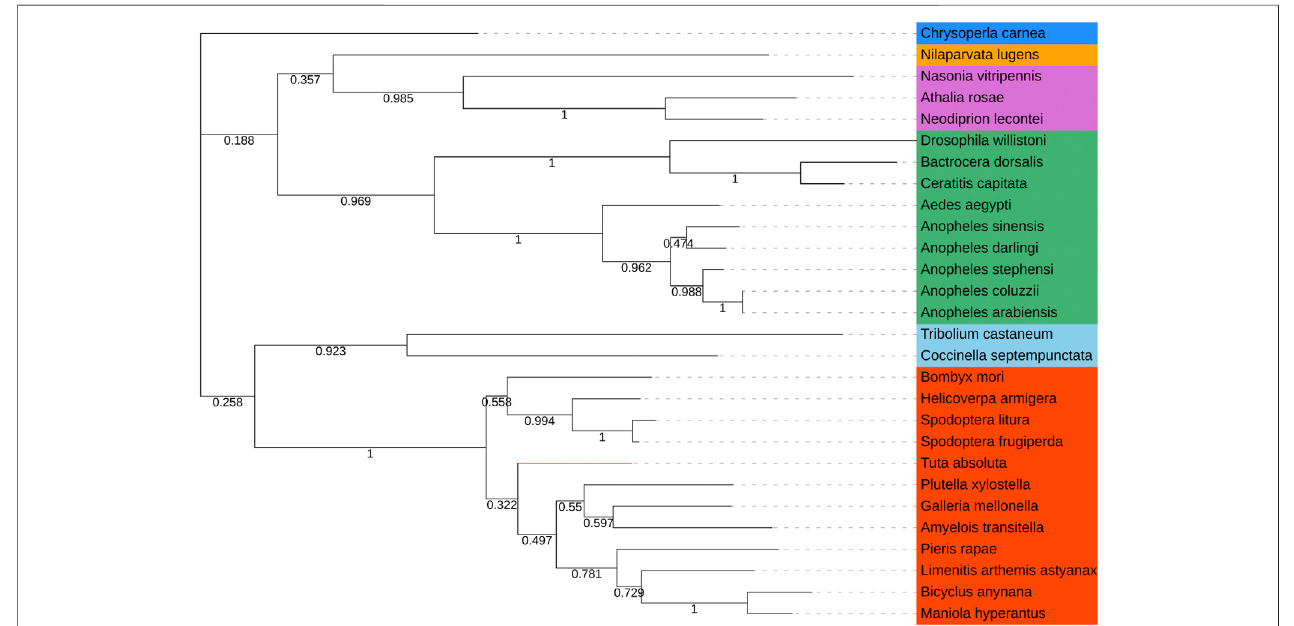
FIGURE2| Phylogenetictreebasedontheknownaminoacidsequencesof cinnabar genes.Thephylogenetictreewasconstructedusingthemaximumlikelihood methodwith 1,000 bootstrap replications inMEGA7.0 Software. Values at the nodes are bootstrap values based on 1,000 replicates. Lepidoptera was depicted in red, Coleoptera in sky blue, Diptera in green, Hymenoptera in orchid, Hemiptera in orange, and Neuroptera in doderblue. Helicoverpa armigera (XP_021183543.1), Spodoptera frugiperda (XP_035436851.1), Spodoptera litura (XP_022820213.1), Maniola hyperantus (XP_034840116.1), Limenitis arthemis